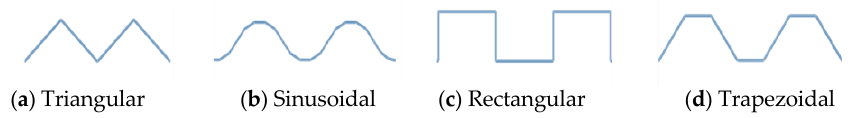
Figure 1. Topologies commonly used in corrugated core sandwich panels. ( a ) Triangular; ( b ) Si- nusoidal; ( c ) Rectangular; ( d ) Trapezoidal. ( b ) Sinusoidal; ( c ) Rectangular; ( d )